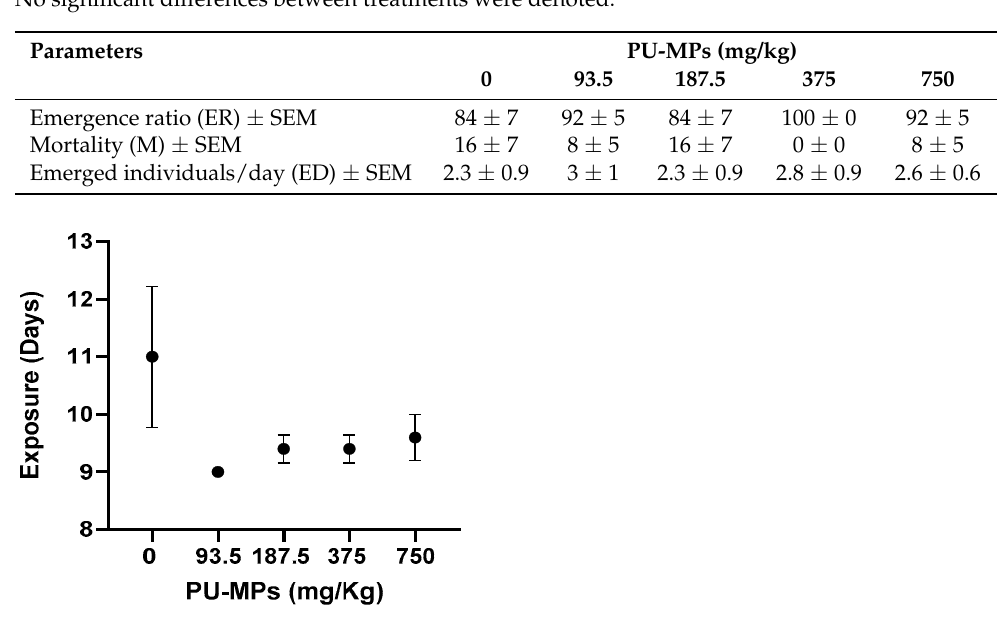
Figure 2. Effect of different concentrations of polyurethane microplastics (PU-MPs) on Chironomus riparius first day of emergence (n = 5). All values are presented as mean ± standard error of the mean. No significant differences between treatments were denoted.